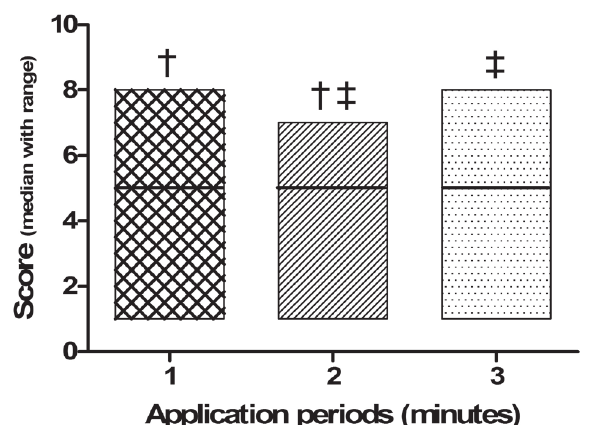
Figure 2- Median with range of the scores obtained for the five concentrations of citric acid and the control group. Figure 3- Median with range of the scores obtained for the three application periods of the citric acid.